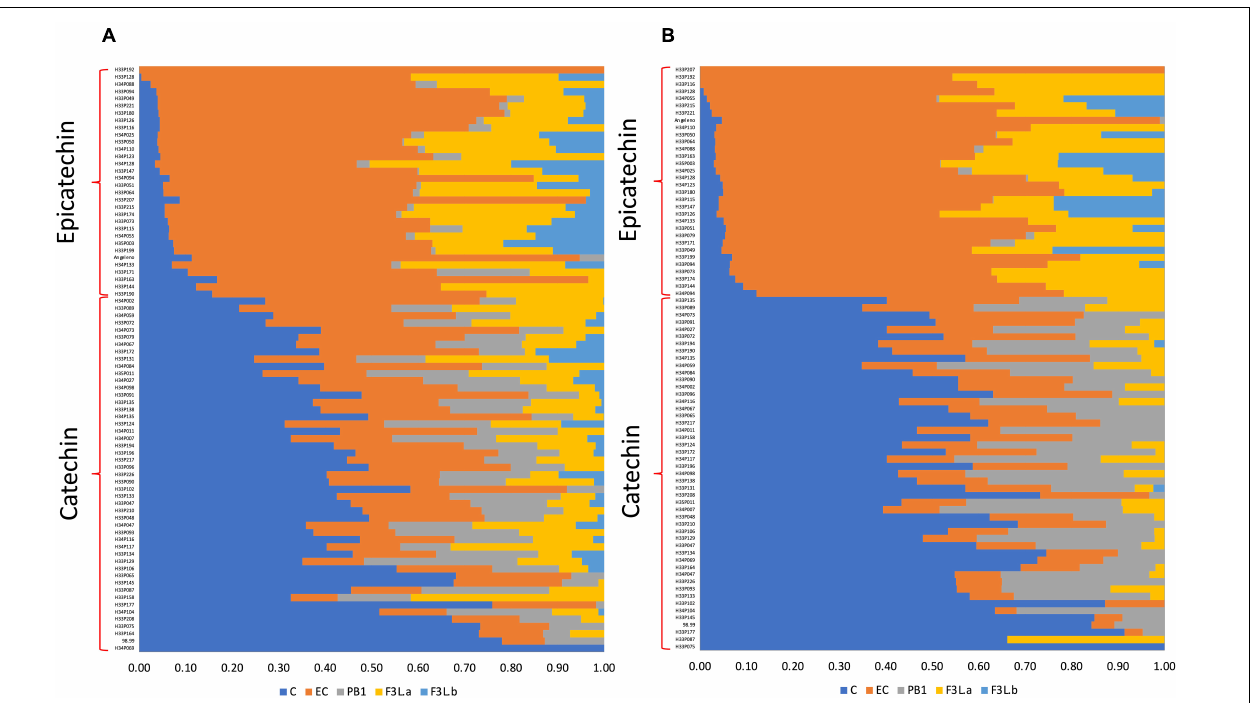
FIGURE 4 | The relative content of flavan-3-ols identified in the flesh (A) and skin (B) of the Japanese plum fruits from an F1 progeny ( < ‘98–99’ × ‘Angeleno’) in T1. Data from the parents were included in each tissue. Data correspond to the relative content of each flavan-3-ol, in relation to the total amount of flavan-3-ols in the tissue, measured by the HPLC-DAD technique. C, catechin; EC, epicatechin; PA2, proanthocyanidin A2; PB1, proanthocyanidin B1; FL3-a and F3L-b, two flavan-3-ol dimers denoted as “a” and